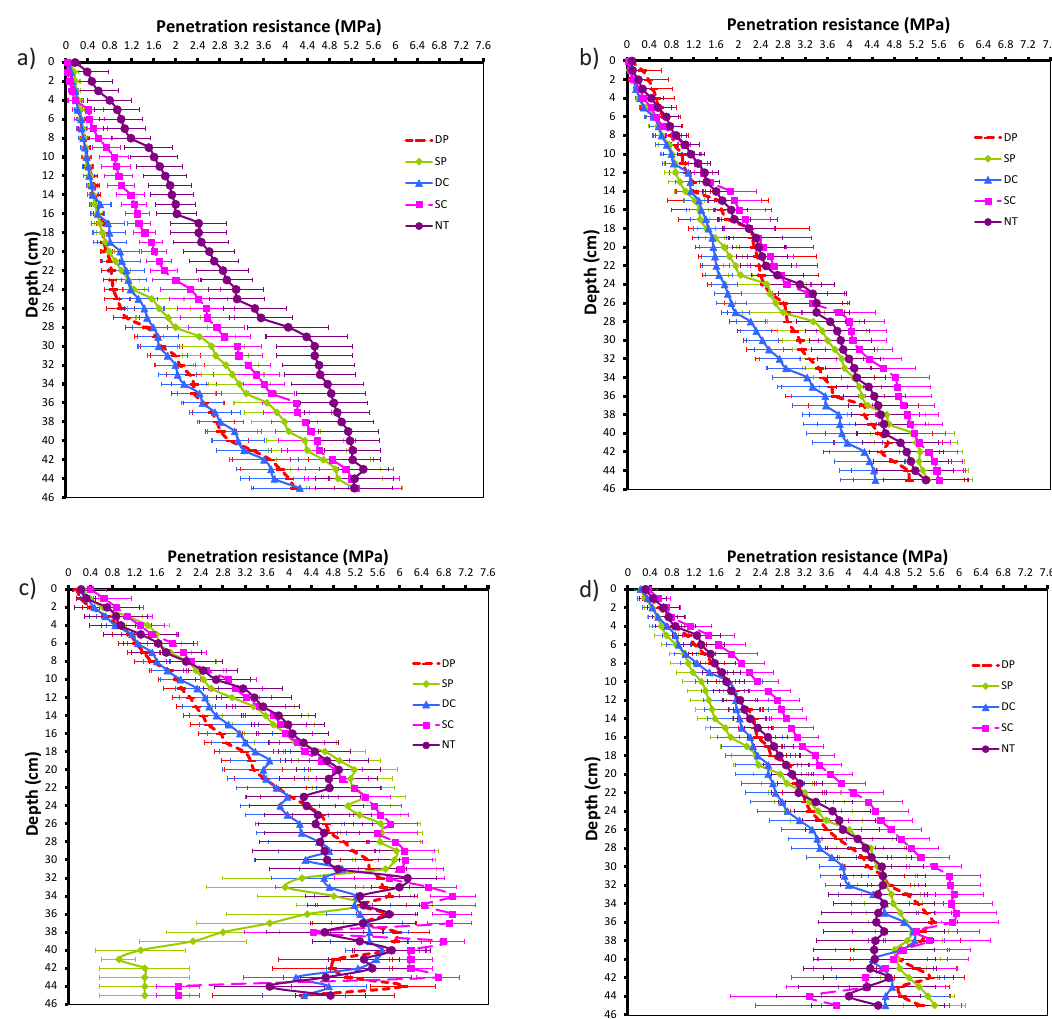
Fig. 1. Soil penetration resistance at different stages of experiment in 2016: a) before pre-sowing tillage in spring; b) after faba bean sowing; c) beginning of faba bean flowering; d) after harvesting. DP = deep ploughing, SP = shallow ploughing, DC = deep cultivation, SC = shallow cultivation, NT = no-tillage (direct drilling). Horizontal bars mean standard